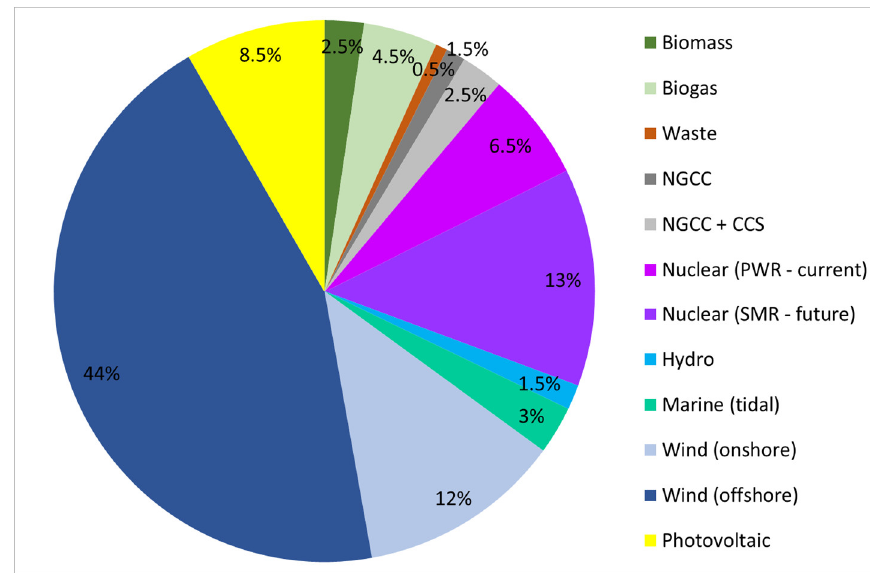
Figure 3. Expected UK grid mix composition in 2050, in terms of total electricity generated (under “2 degrees” scenario assumptions). NGCC = natural gas combined cycles; NGCC + CCS = natural gas combined cycles plus carbon capture and storage; PWR = pressure water reactors; SMR = small modular reactors.